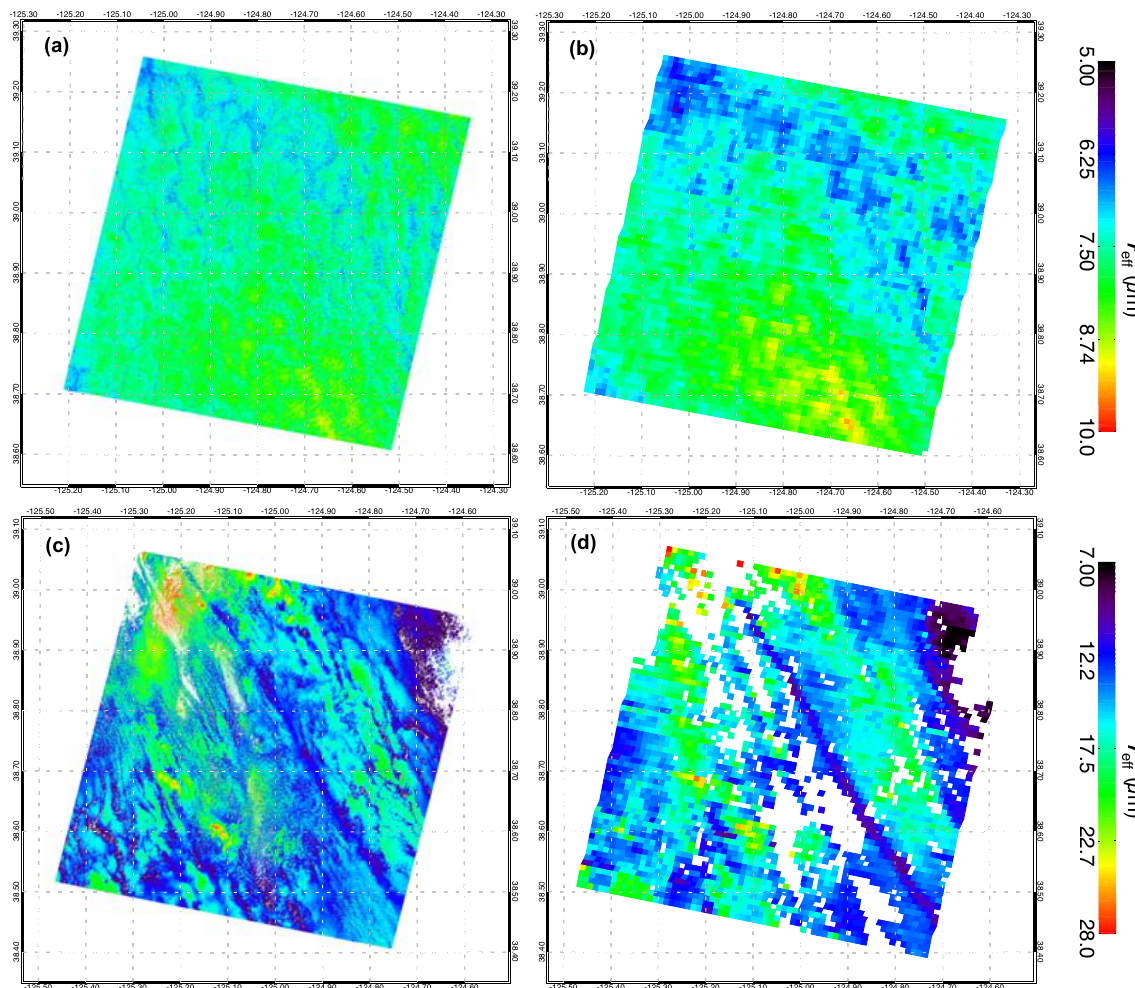
Figure 8. (a) Map of retrieved effective droplet radius from reflectances sampled by ASTER ( r eff , A ) on 13 May 2003 (scene C14). (b) Same as (a) but showing the operational MODIS retrieved effective droplet radius ( r eff , M ). (c) – (d) Same as (a) – (b) but for observations on 10 June 2005 (scene C19). The corresponding single-band grayscale images of ASTER band 3N and MODIS band 2 reflectances are shown in Fig.